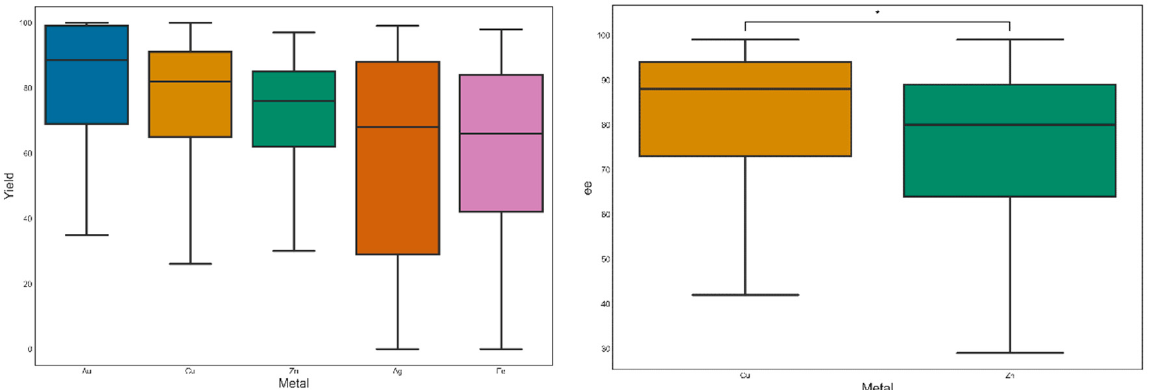
Figure 7. ( left ) Yields of different metals with more than 50 entries ( right ) ee of enantioselective A 3 reactions ( ee > 0). Statistical analysis performed using Student’s t -test ( p = 0.013). Symbol Meaning: * p ≤ 0.05 (For the last two choices only).